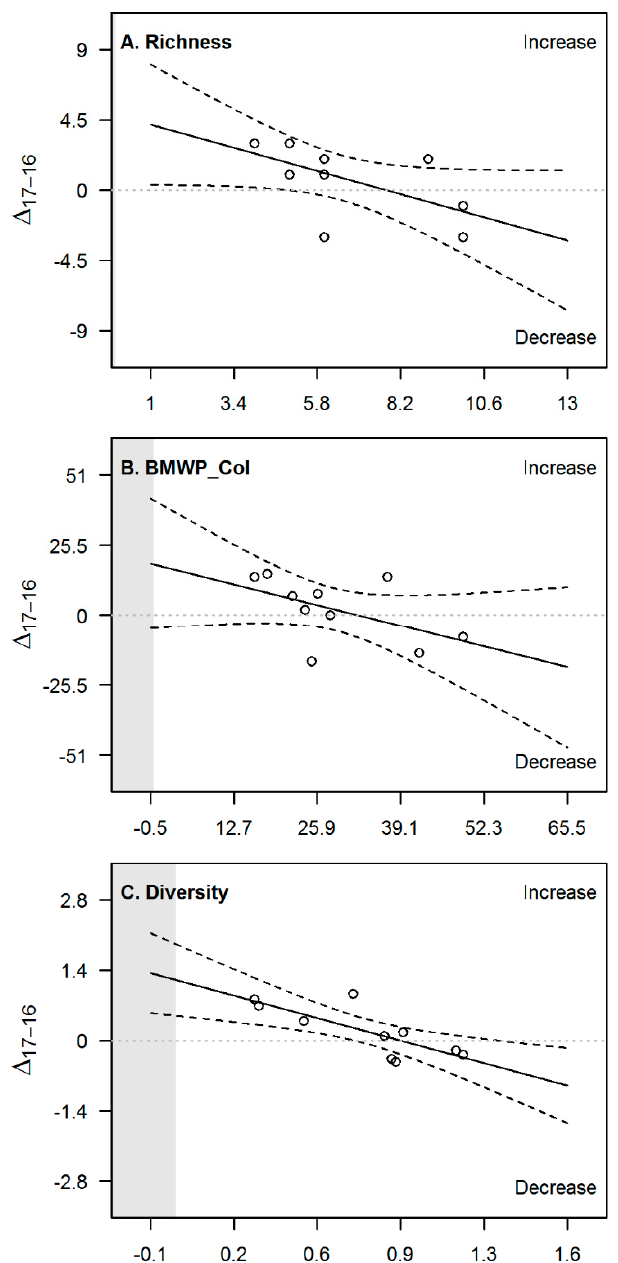
Figure 6. Linear regression lines depicting the change in biotic metrics between 2016 and 2017. Open circles represent the sample sites, the solid black line the fitted trend, and the dotted black lines the confidence (95%) related to it. ( A ) Richness; ( B ) Biological Monitoring Working Party (Colombia) (BMWP_Col); ( C ) diversity. Only diversity values showed a significant negative slope ( − 1.30, p = 0.008). The depicted x -range covered 2.5 times the initial range, thereby including negative values (gray zones). Table 3. Results of linear analyses relating the observed differences between 2016 and 2017 ( ∆ 17 − 16 ), with the observations made in 2016 as represented in Figures 4–6. Slope values are given with their accompanying p -value and 95% confidence interval (CI). The R ² value describes the model fit to the observations. The significance of the slope value is indicated for p < 0.01 (**) and for p < 0.001 (***). Variable Slope p -Value R 2 CI 2.5% CI 97.5% pH − 0.49 *** 0.00002 0.90 − 0.61 − 0.36